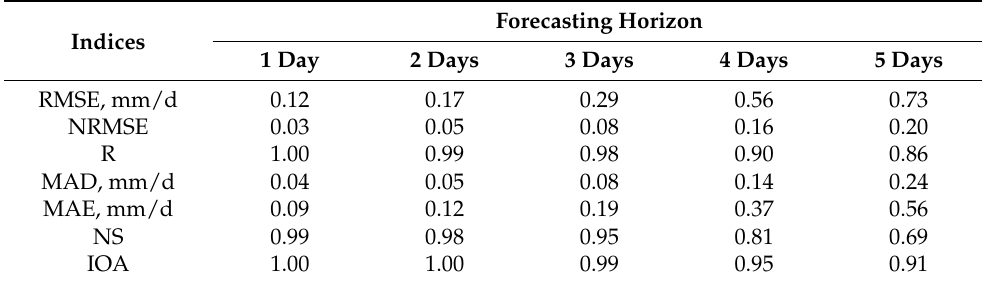
Table 15. Multi-day-ahead forecasting performance of the Bi-LSTM model on the test dataset at Ishurdi station. Forecasting Horizon Indices 1